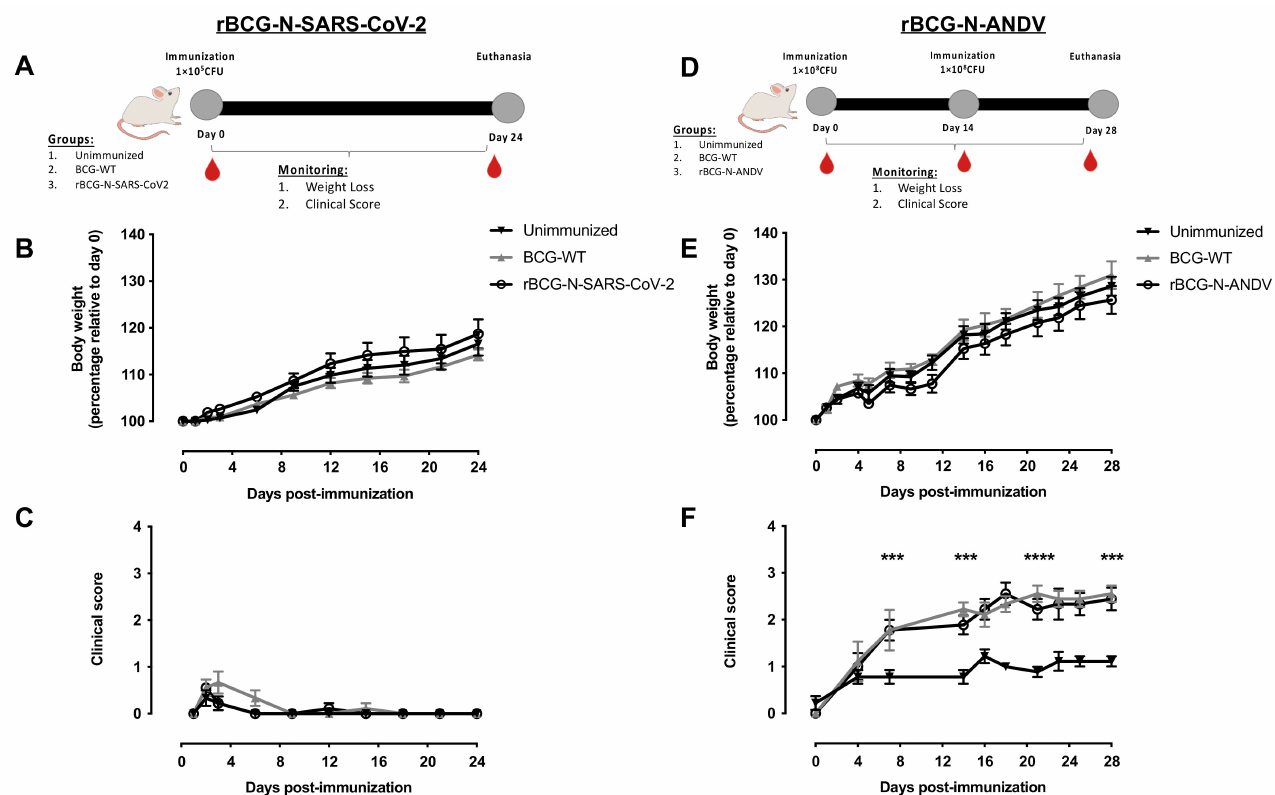
Figure 1. Determination of safety parameters after the administration of recombinant vaccines. The experimental schedule of immunization for rBCG-N-SARS-CoV-2 ( A ) and rBCG-N-ANDV ( D ) is presented. Safety parameters such as monitoring of weight loss for rBCG-N-SARS-CoV-2 ( B ) or rBCG-N-ANDV ( E ) and the clinical score for rBCG-N-SARS-CoV-2 ( C ), or rBCG-N-ANDV ( F ) are shown. Data are representative of 3 independent experiments. Each experiment considered a total of three mice per group. Statistical differences were assessed by one-way ANOVA with a post hoc Tukey test. Differences were only found in ( F ), with the BCG-WT and the rBCG-N-ANDV being statistically higher than the unimmunized mice. ***: p < 0001; ****: p <